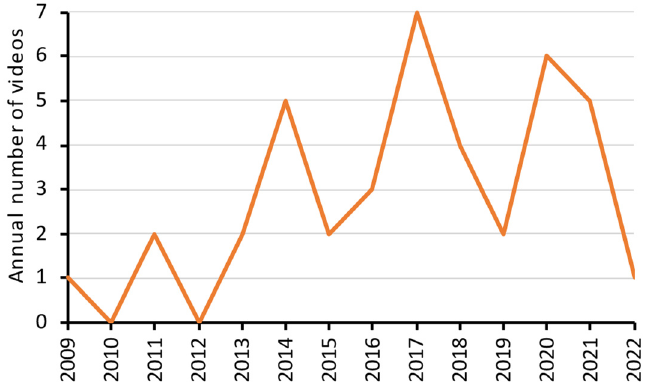
Figure 2. Number of YouTube videos uploaded each year that demonstrated panoramic radiography.